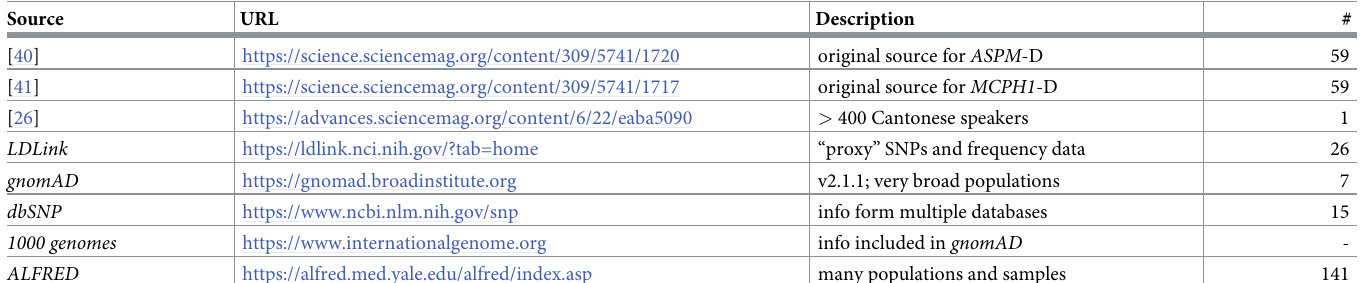
Table 1. Data sources used for estimating the population frequency of the “derived” alleles, including the number of samples/populations (column “#”) for which such data was available. Source URL